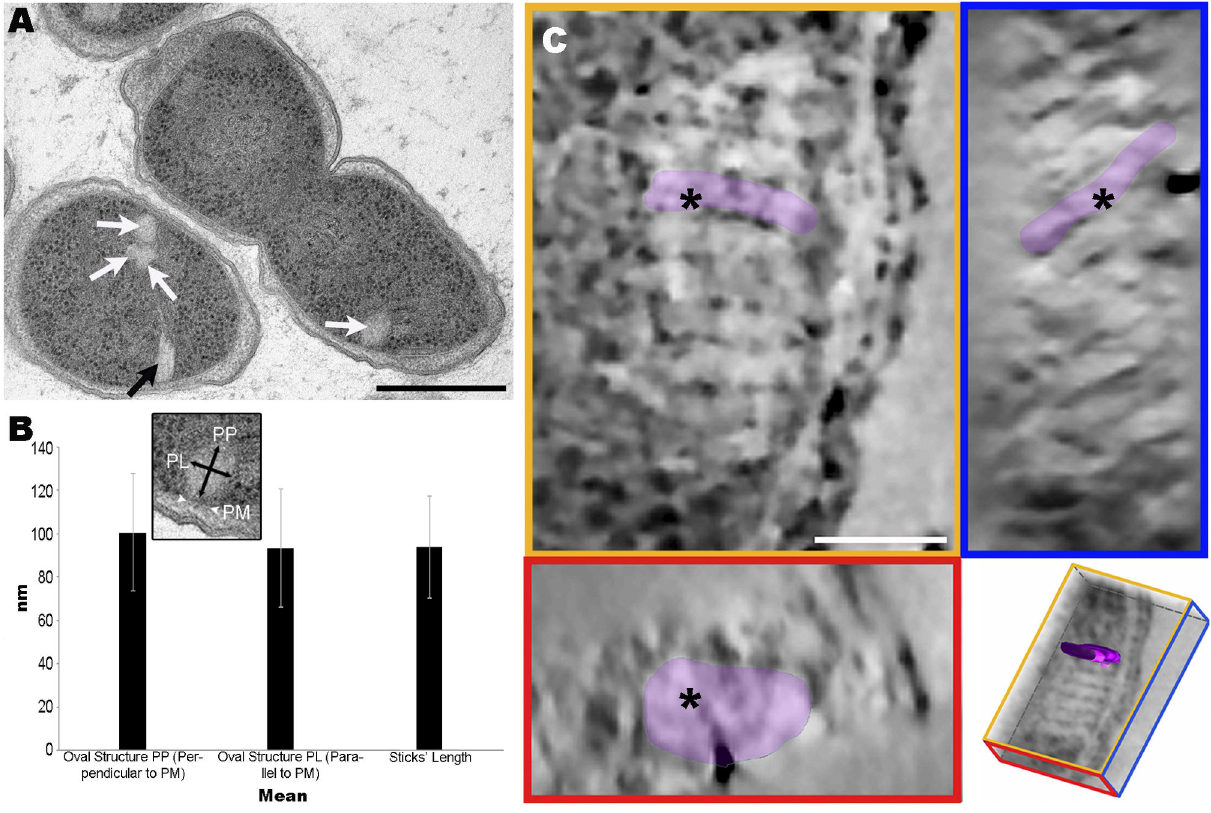
Figure 2. TEM analysis of oval structures observed in P. deceptionensis M1 T TSA-grown cultures processed by HPF- FS. (A) A 60 nm Epon section showing a stack (black arrow) and oval structures (white arrows). Scale bar = 250 nm. (B) Graph comparing the oval structure measurements (PP, PL) and the length of the sticks. The error bars correspond to standard deviation values (SD) (PP). Perpendicular; (PL) Parallel; (PM) Plasma membrane. (C) 4 nm tomogram slices from the XYZ views of a bbif- filtered tomogram reconstructed from 250 nm Epon sections. The asterisks correspond to the same point through the different views XYZ. The XY view (top-left image) reveals a stack perpendicular to the PM, in which one clustered unit has been colored. The YZ view (top-right image) shows the same stack in which sticks are distributed obliquely within the section. The dyed unit corresponds to the one colored before. The XZ view (bottom-left image) shows the same dyed stick observed as an oval structure. The bottom right picture corresponds to a scheme of the view’s distribution in the tomogram where the highlighted unit has been segmented. Scale bar = 50